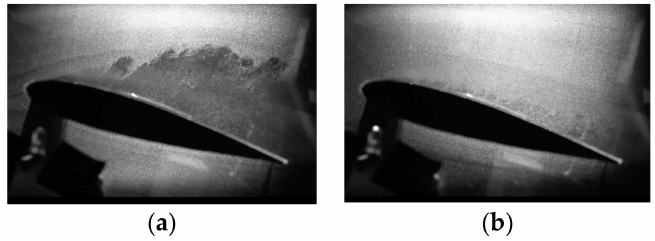
Figure 2. Flow control with the DBD plasma actuator (Experiment): ( a ) DBD-PA (dielectric barrier discharge plasma actuator) OFF; and ( b ) DBD-PA ON with burst mode.